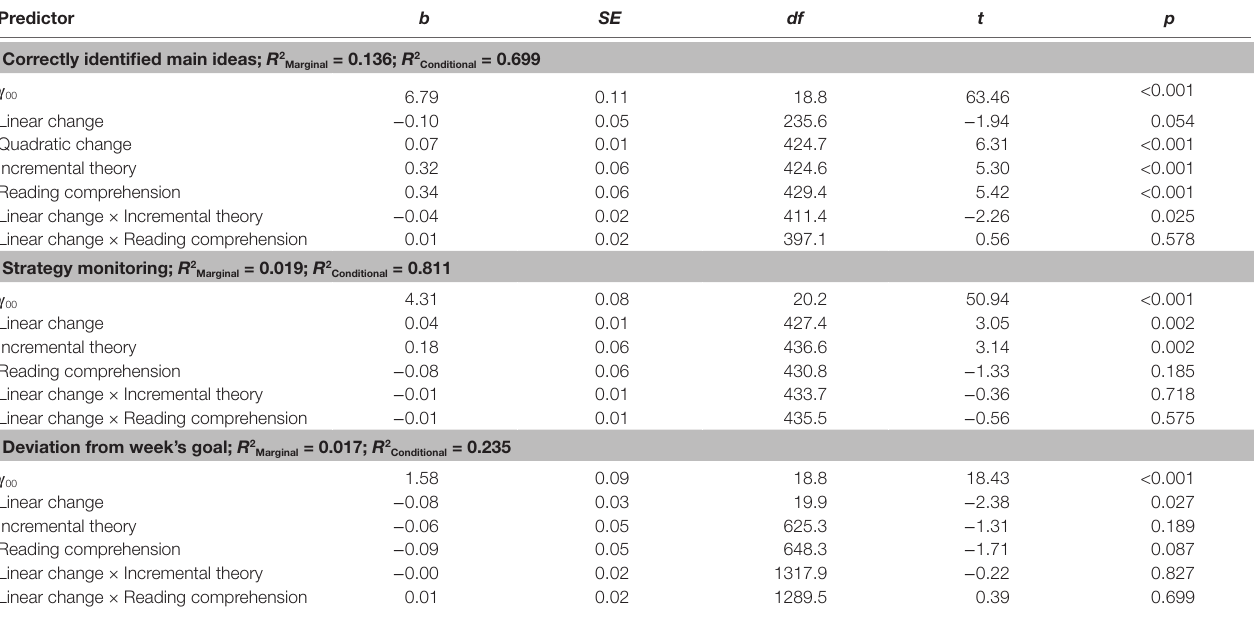
TABLE 5 | Linear mixed-effects models predicting the behavior-proximal measures of strategy use. Predictor b SE df